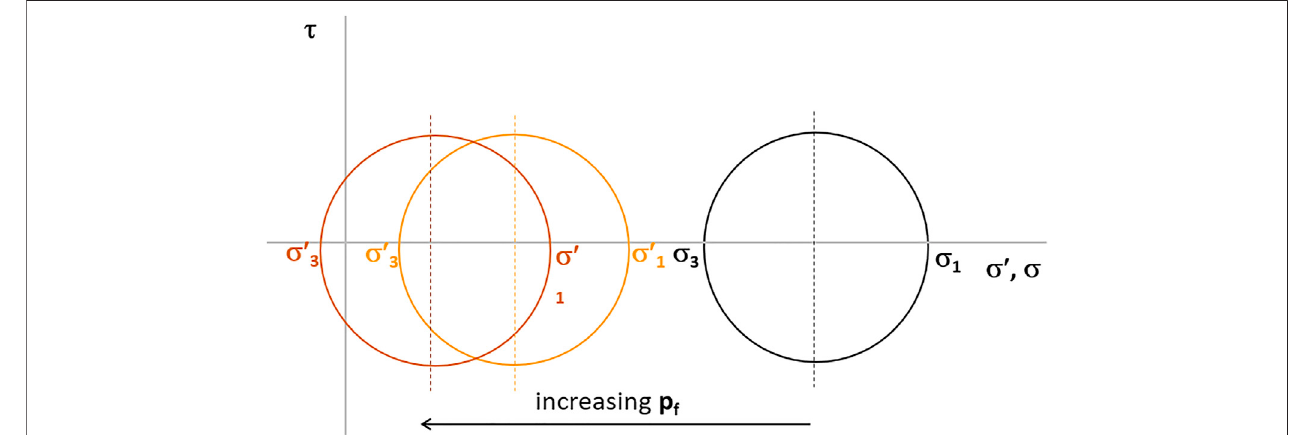
FIGURE 3 | Effect of pore pressure increase on the effective stresses.